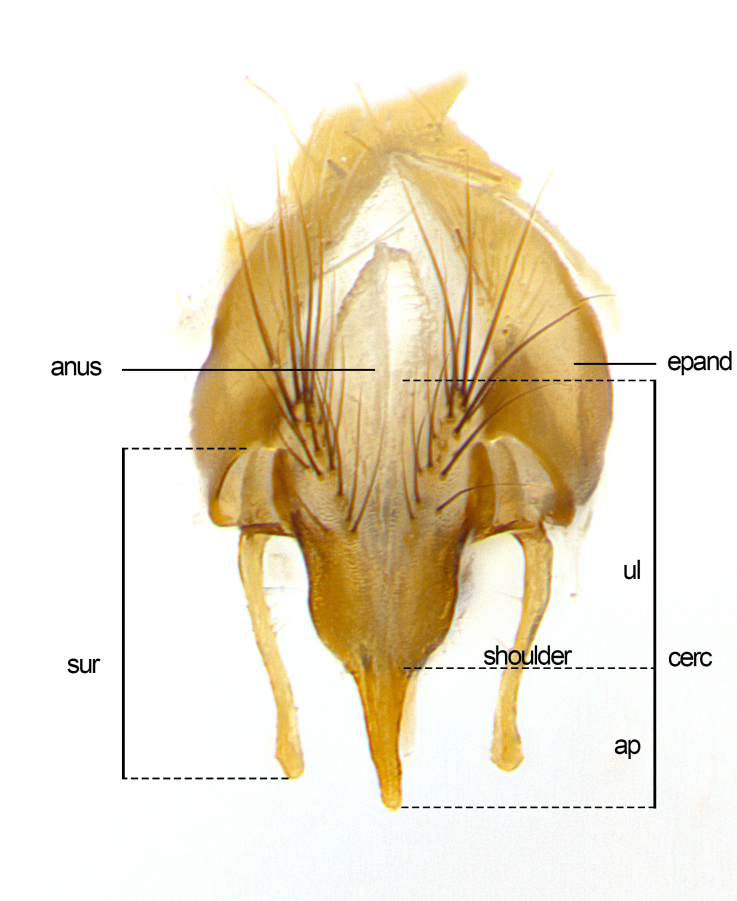
abbreviations for sections measured: anus = anal operculum; ap = apical section of cercus; epand = epandrium; ul = upper lobe of cercus; shoulder = shoulder point between apical section and upper lobe of cercus; sur = surstylus.